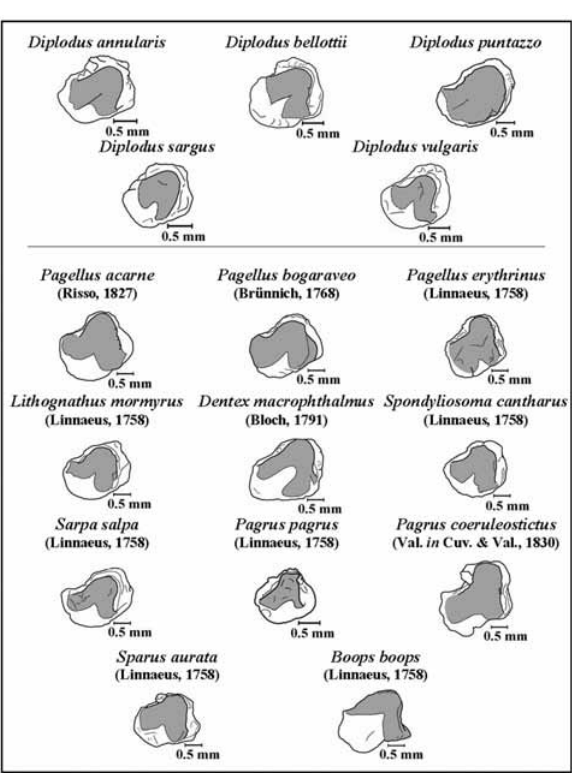
F IG . 17. – Ventral face of the right lapilli of five species of genus Diplodus and of several other species of the family Sparidae, to allow a comparison between them. The shaded area corresponds to the gibbus maculae . All otoliths are represented with the lateral margin to the top of the page and anterior region to the